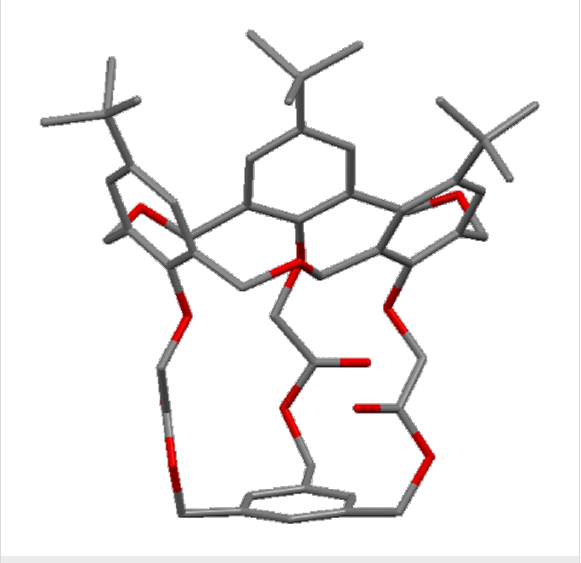
Figure 9: X-ray crystal structure of 18 (CCDC ID 142599)